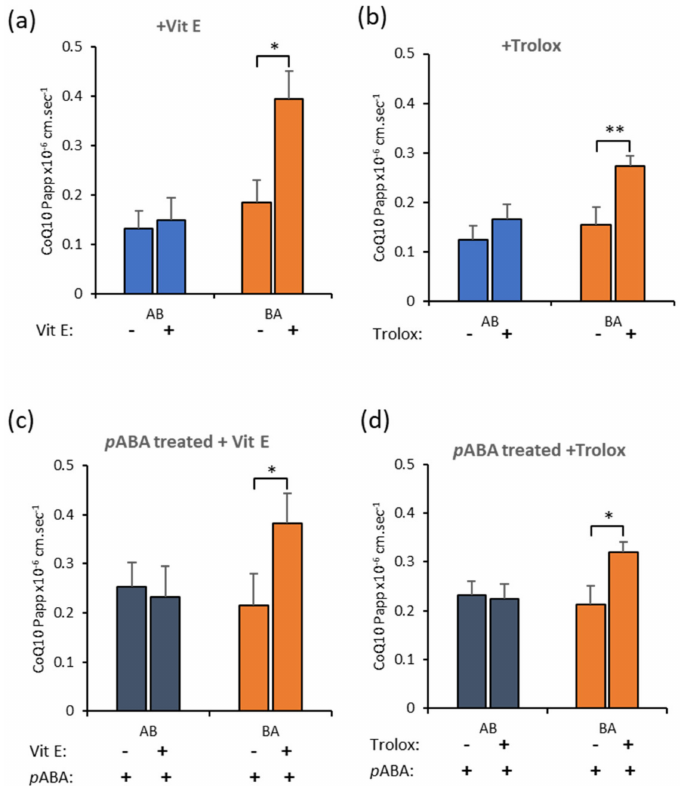
Figure 6. Antioxidants increase CoQ 10 movement toward the blood side in bEnd.3 cells. Transport of CoQ 10 across bEnd.3 monolayers on Transwell filters. CoQ 10 (10 µ M) was co-administered with either ( a ) vitamin E (50 µ M) or ( b ) Trolox (50 µ M) in control cells. Transport of CoQ 10 in the direction B to A (toward blood side) was enhanced. In p ABA treated cells to deplete CoQ 10 , the e ff ect persisted and both ( c ) vitamin E and ( d ) Trolox enhanced B to A transport. Values are mean ± SEM; n = 4–6; * p < 0.05, ** p <